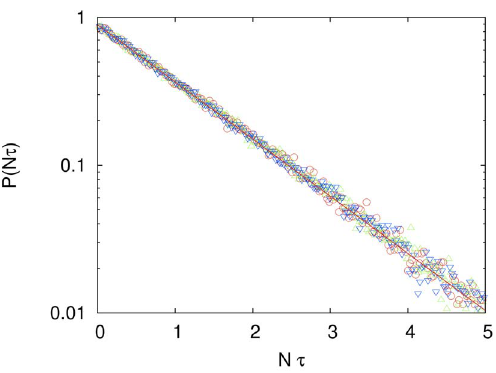
Figure 1. Exponential distribution of the rescaled computa- tional cost for the independent search. Probability distribution P N t ð Þ that a search employing N independent agents finds the solution of the cryptarithmetic problem (1) using a total of Nt (cid:2) updates for N ~ 5 (green triangles), N ~ 10 (blue inverted triangles) and N ~ 20 (red circles). Here t ~ t (cid:2) = 10 ! is the ratio between number of trials to success and the size of the solution space. These distributions were generated using 10 5 independent searches for each N . The solid straight line is the exponential distribution P ( N t ) ~ a exp { aN t ð Þ with a ~ 1 = 1 : 14 . The influence network size M does not affect these results since imitation is not allowed in this case.